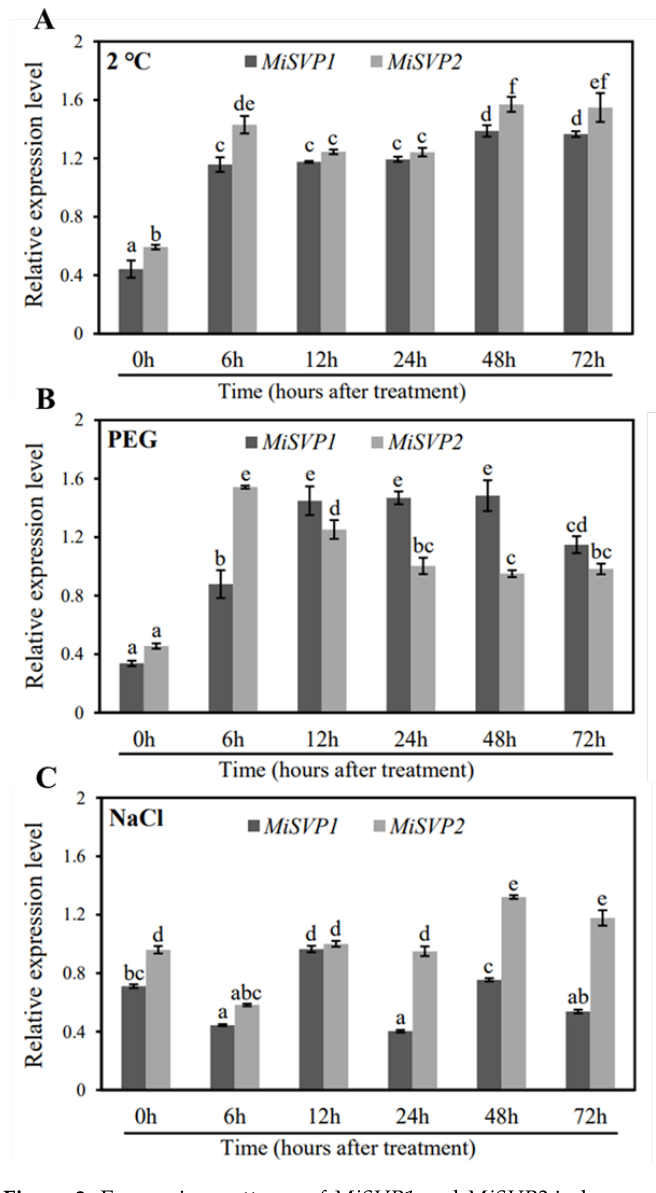
Figure 3. Expression patterns of MiSVP1 and MiSVP2 in leaves under stress treatments. ( A ) 2 °C (low temperature) treatment. ( B ) PEG treatment. ( C ) NaCl treatment. Duncan’s multiple range test was used to analyze the significance of differences among multiple groups of samples, and p < 0.05 indicated a significant difference. The error bars represent the standard error of the mean (± SE) among three replicates of the same sample.